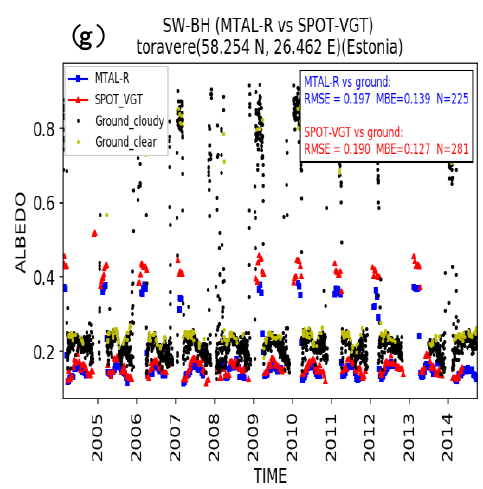
Figure 3. Time series of MTAL-R against ground measurements for a set of ground stations: ( a ) Agoufou; ( b ) Banizoumbou; ( c ) Evora; ( d ) Gobabeb; ( e ) Niamey; ( f ) Payerne and ( g ) Toravere. SPOT-VGT derived equivalent albedo measurements are also presented. Difference statistics (root mean square error (RMSE), and mean bias error (MBE)) between satellite estimates and ground measurements are included. N is the number of satellite albedo estimates for which a ground measurement is available (and thus, the number of estimates used to calculate the statistics).